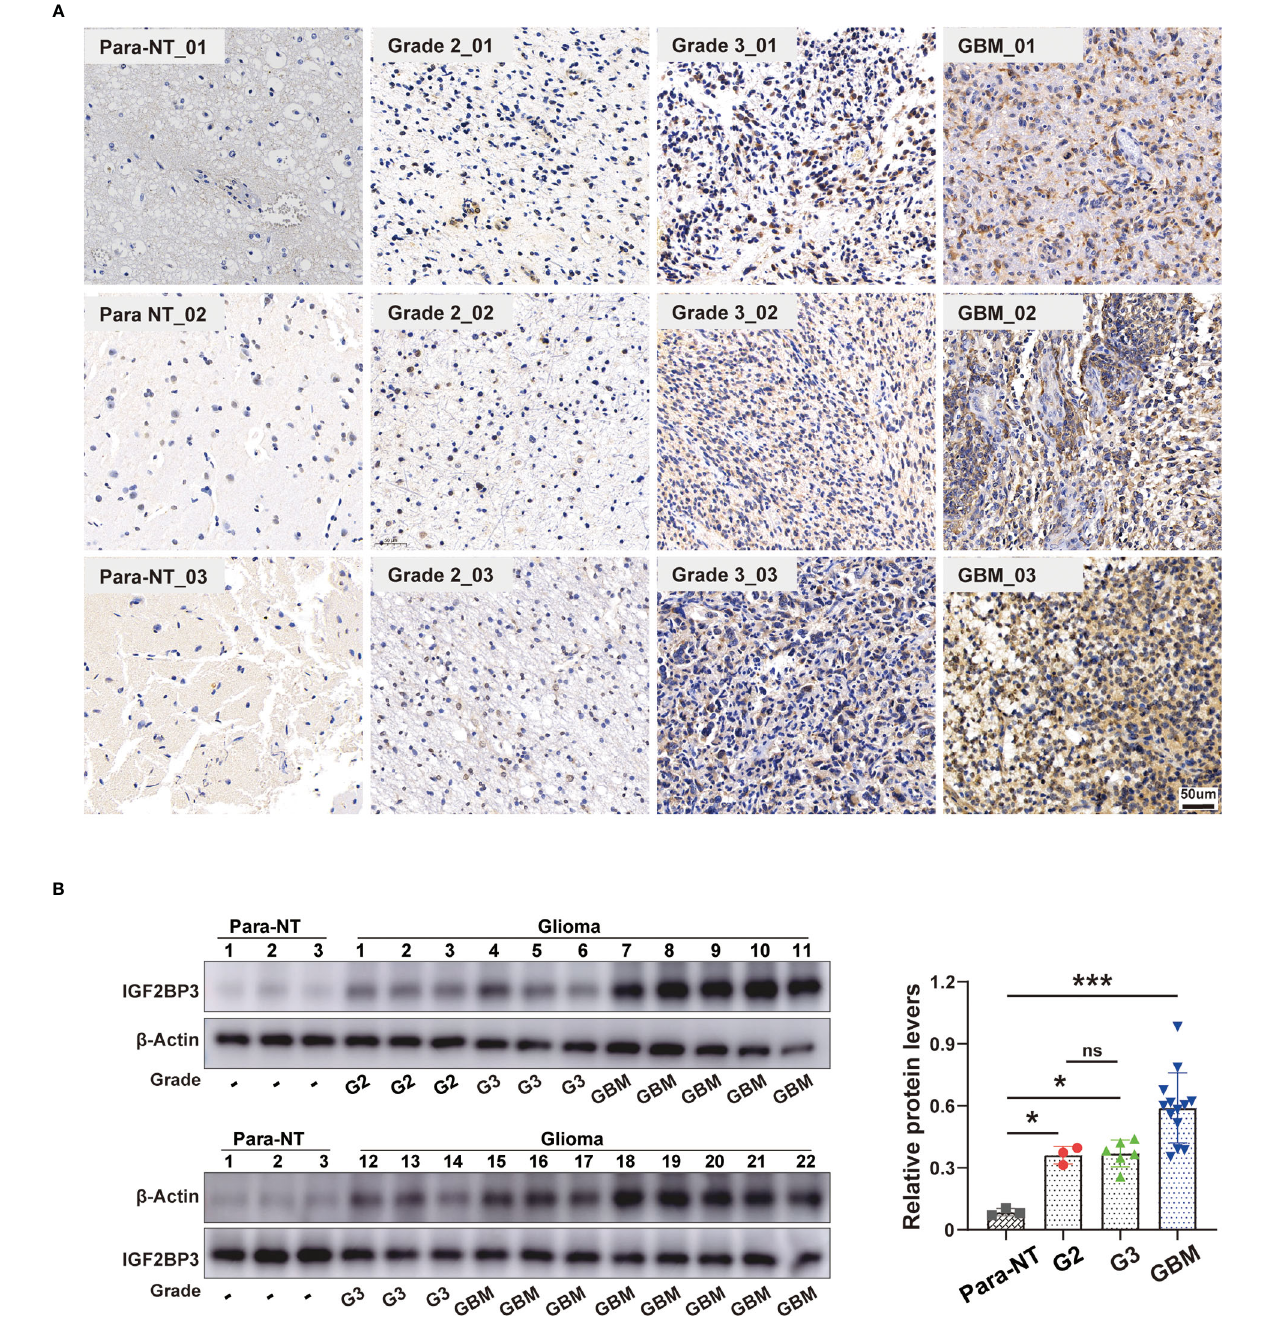
FIGURE 14 Validation of IGF2BP3 Expression in Glioma. (A) Representative immunohistochemical staining of IGF2BP3 expression in clinical glioma tissue and normal peritumor tissues. Scale bar=50 m m. (B) Western blot analysis of IGF2BP3 protein level in human glioma patient samples (grade 2 (n = 3), grade 3 (n = 6), grade GBM (n = 13)) and normal peritumor brain tissues (n = 3). b -actin was used as a loading control. All data are shown as the mean ± SD (at least three independent experiments). ns, no signi fi cance, *P <0.05, ***P <